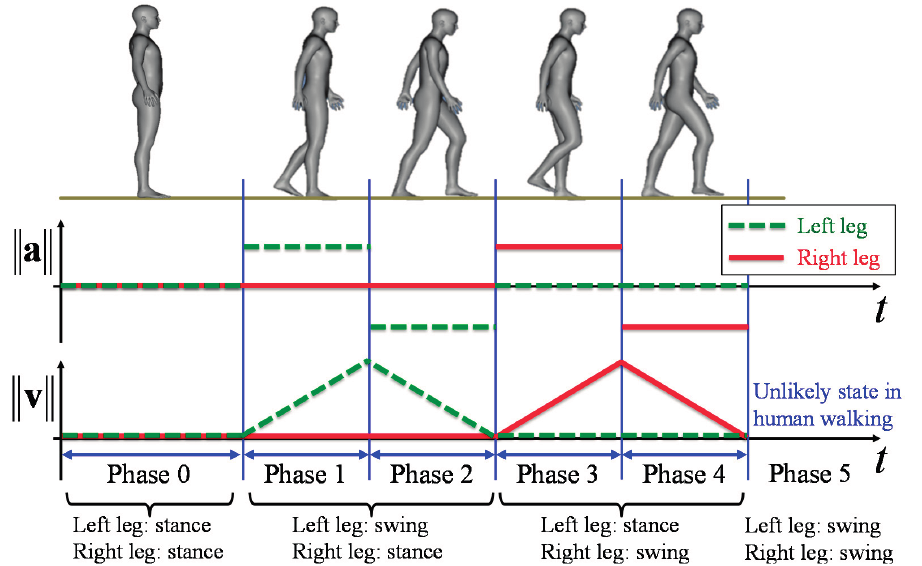
Figure 6. A simplified human walking